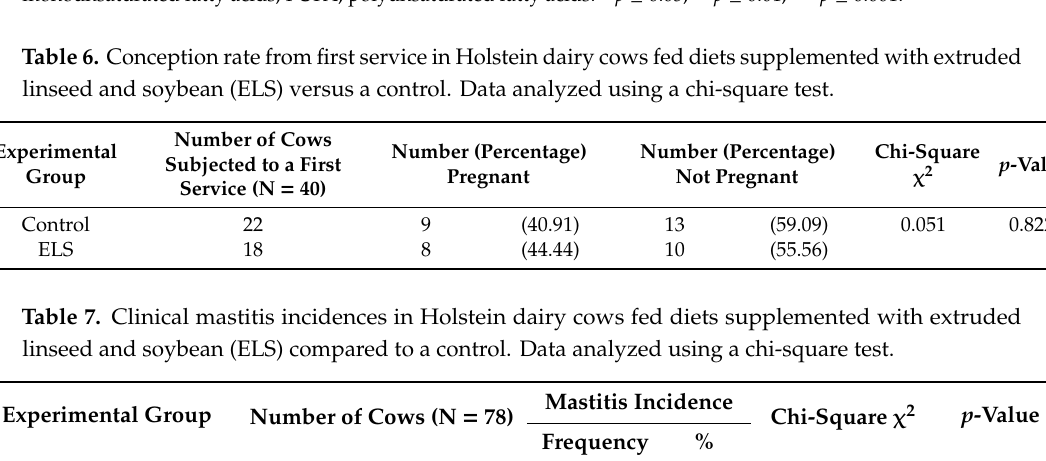
Table 6. Conception rate from first service in Holstein dairy cows fed diets supplemented with extruded